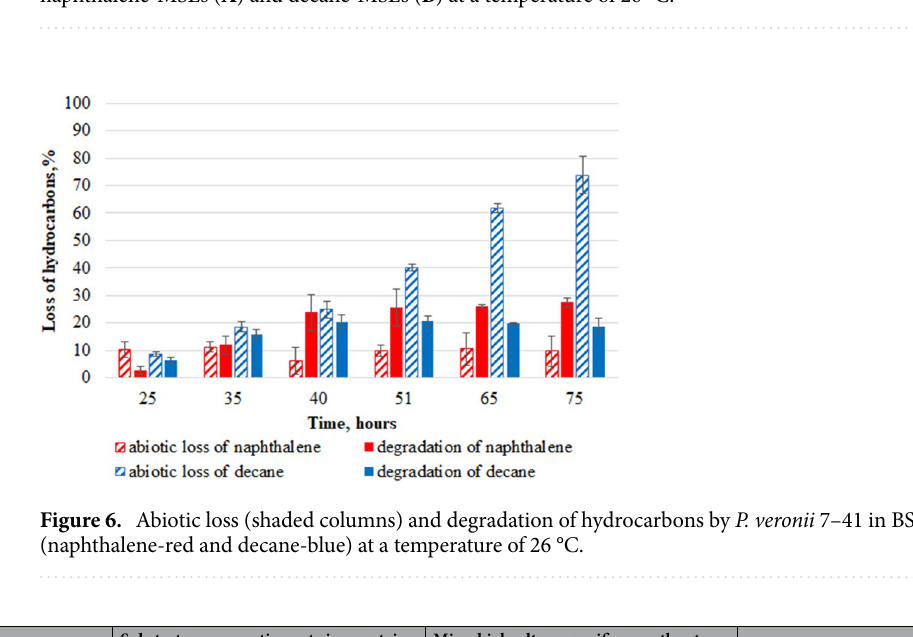
Figure 5. Abiotic loss (shaded columns) and degradation of hydrocarbons by P. veronii 7–41 in the naphthalene-MSEs ( A ) and decane-MSEs ( B ) at a temperature of 26 °C.